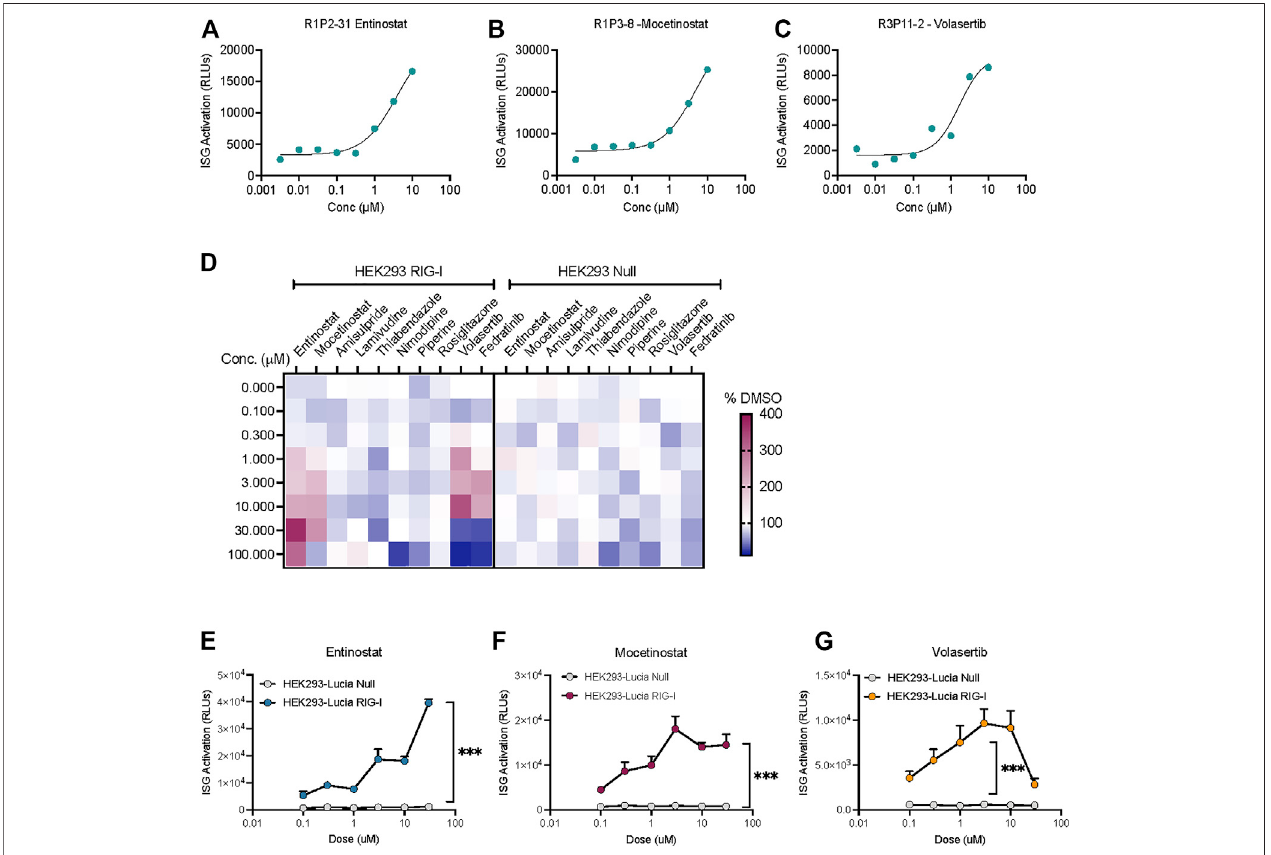
FIGURE3| HDAC inhibitors and a PLK inhibitor increase ISG activation in a RIG-I dependent manner. Dose response curves showing low μ M activation of ISG-luciferase by (A,B) HDAC inhibitors Entinostat and Mocetinostat and (C) PLK1 inhibitor volasertib. (D) Heatmap depicts % change vs DMSO treatment for top 10hitsin thesamecellline. (E – G) Comparison ofdosedependentISG-Luciferase activation bythedrugsin Null vs RIG-I expressing reportercelllines. *** p < 0.001 by 2-way ANOVA with Sidak ’ s post-hoc correction.